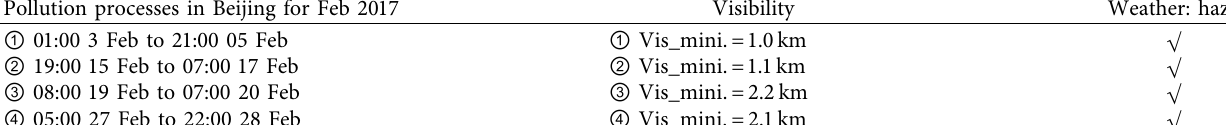
Table 3: Weather phenomena and atmospheric aerosol elements of the pollution process in Beijing for February 2017 and 2021. Pollution processes in Beijing for Feb